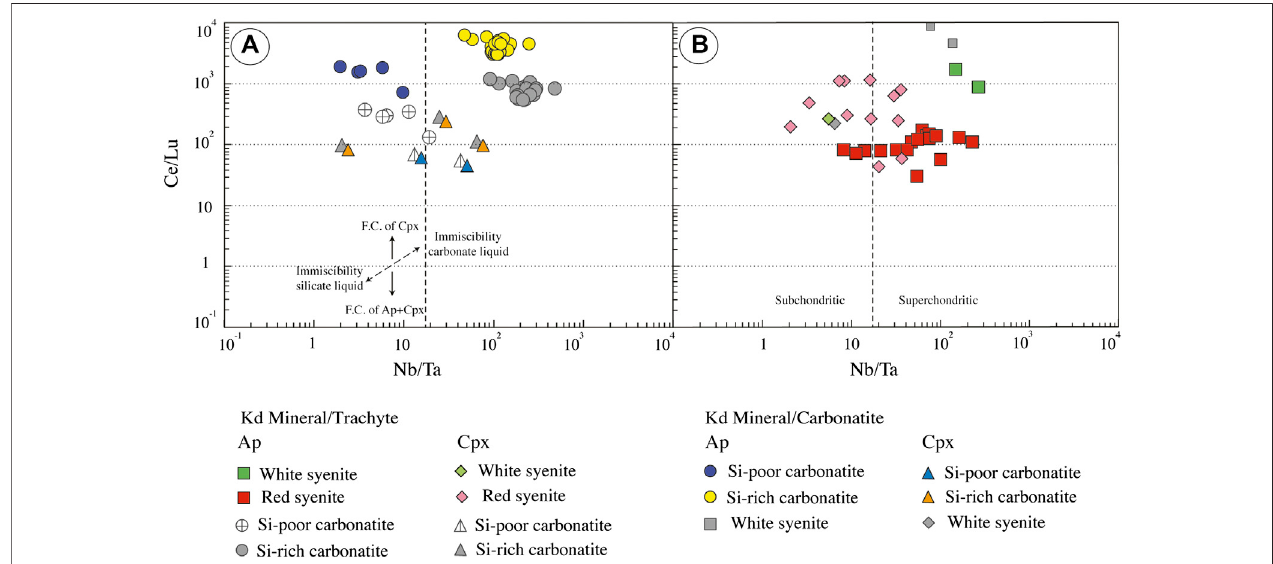
FIGURE13| Calculated equilibriumliquids fromapatite(ap)and clinopyroxene(cpx)composition. (A) Ce/Luvs. Nb/Ta ofIhouhaouenecarbonatites. (B) Ce/Luvs. Nb/Ta of associated syenites. FC: fractional crystallization. For Si-poor and Si-rich carbonatite, we chose partition coef fi cient between carbonatite and apatite from Hammouda et al. (2010) (experiments performed with green apatite from Ihouahouene) and carbonatite and clinopyroxene from Klemme et al. (1995) and Blundy and Dalton (2000). For syenites, we selected partition coef fi cients between silica-rich melt and apatite from Mahood and Stimac (1990) and Prowatke and Klemme (2006) and partition coef fi cients between silica-rich melt and clinopyroxene from Larsen (1979) and Mahood and Stimac